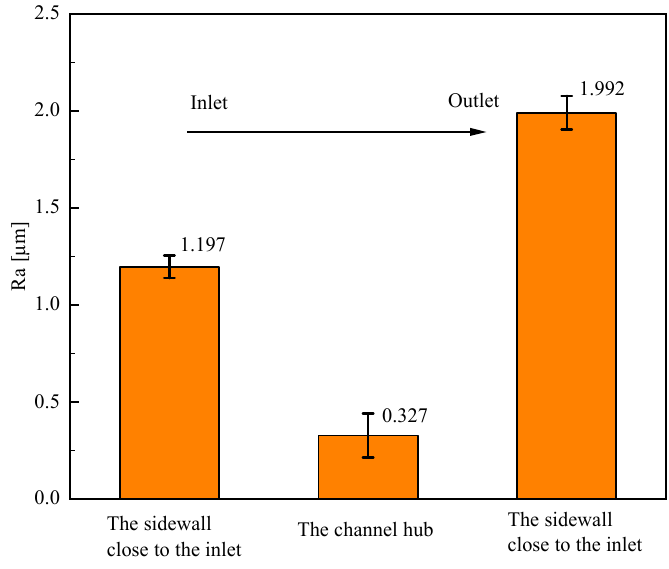
Figure 18. Surface roughness Ra of the channels.